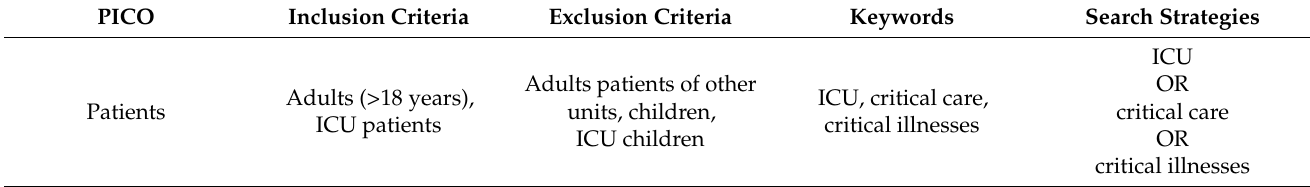
Table 1. PICO criteria used to develop the research question and include or exclude studies. PICO Inclusion Criteria Exclusion Criteria Keywords Search